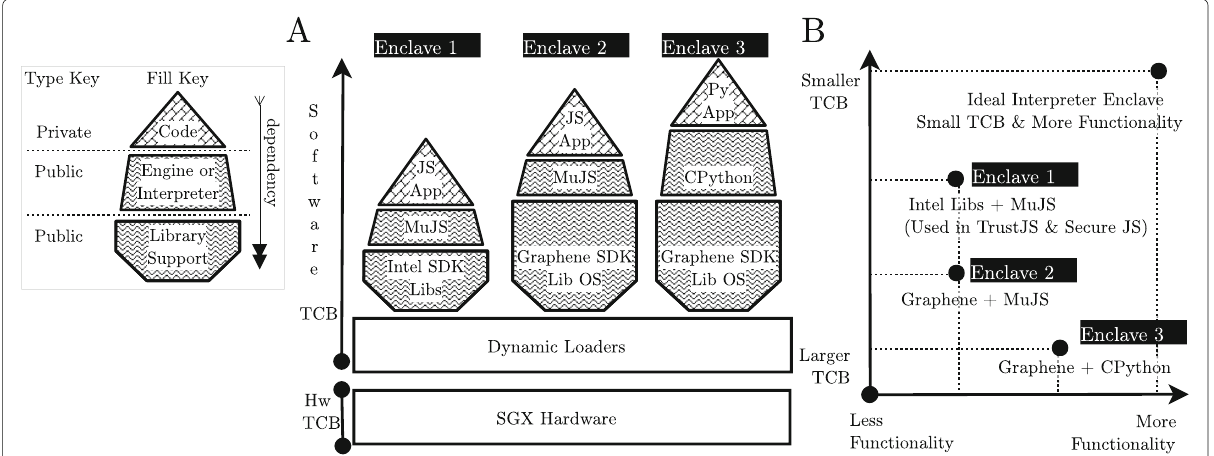
Fig. 3 Three different TCB to deploy Dynamic Code Loaders and Interpreter Enclaves for Private Algorithms. a ) TCB Size may vary depending on SDK and interpreter of the language. Graphene SDK TCB > Intel SDK TCB. CPython TCB > MuJS TCB. b ) TCB Size vs Functional Capabilities in design of Interpreter Enclaves. Ideally, the Interpreter Enclave will provide rich functionalities and will have a small TCB